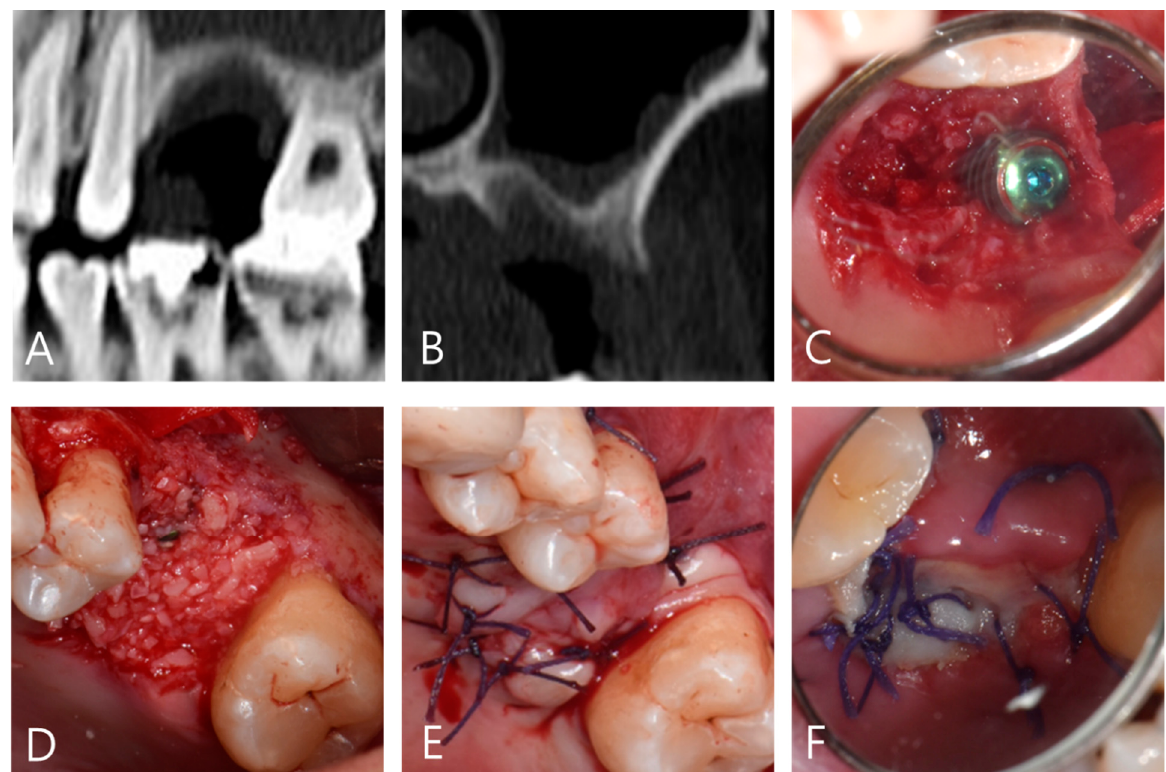
Figure 2. Wound dehiscence after an autogenous tooth bone graft with the collagen membrane of case #1. ( A , B ) Pre-operative radiograph on a left maxillary first molar area with insufficient residual bone for dental implant. ( C ) Implant was placed with a palatal defect. ( D ) Bone graft was performed with DDM/rhBMP-2. ( E ) Primary closure was achieved. ( F ) Wound dehiscence occurred five days after surgery.